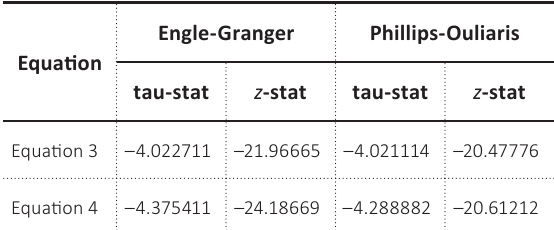
Table 4. DOLS test for cointegration relationship Equation